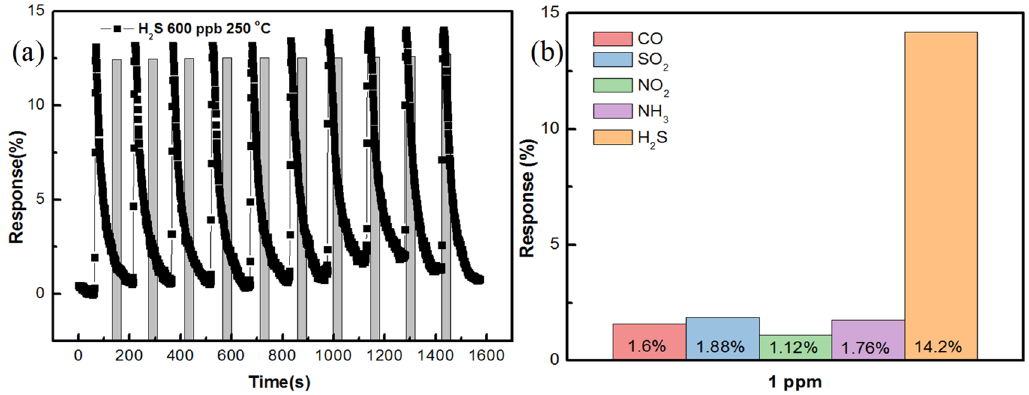
Figure 13. ( a ) Repeatability gas-sensing test; ( b ) selectivity of ZnO sensor for different target gases. The gas-sensing mechanism of the ZnO sensor with H 2 S gas is shown in Figure 14.